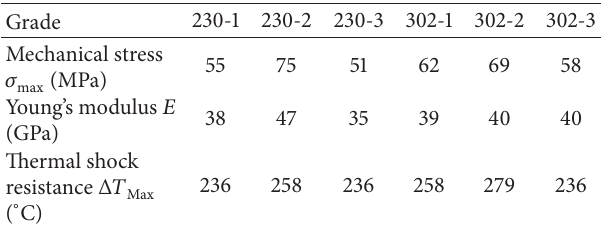
Table 3: Estimated mechanical and thermal properties of the studied porcelain